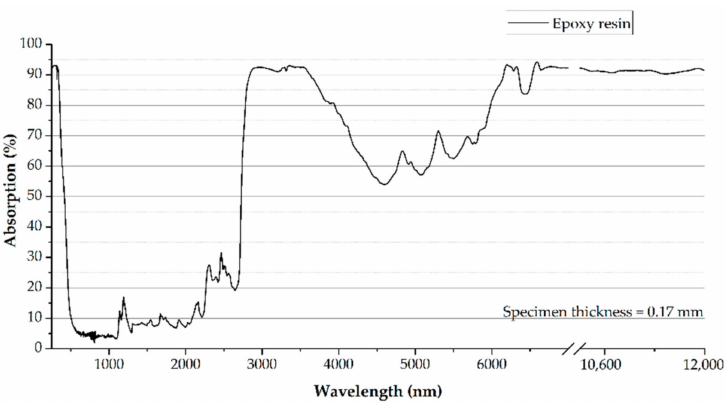
Figure 1. Absorption curve for a typical epoxy resin